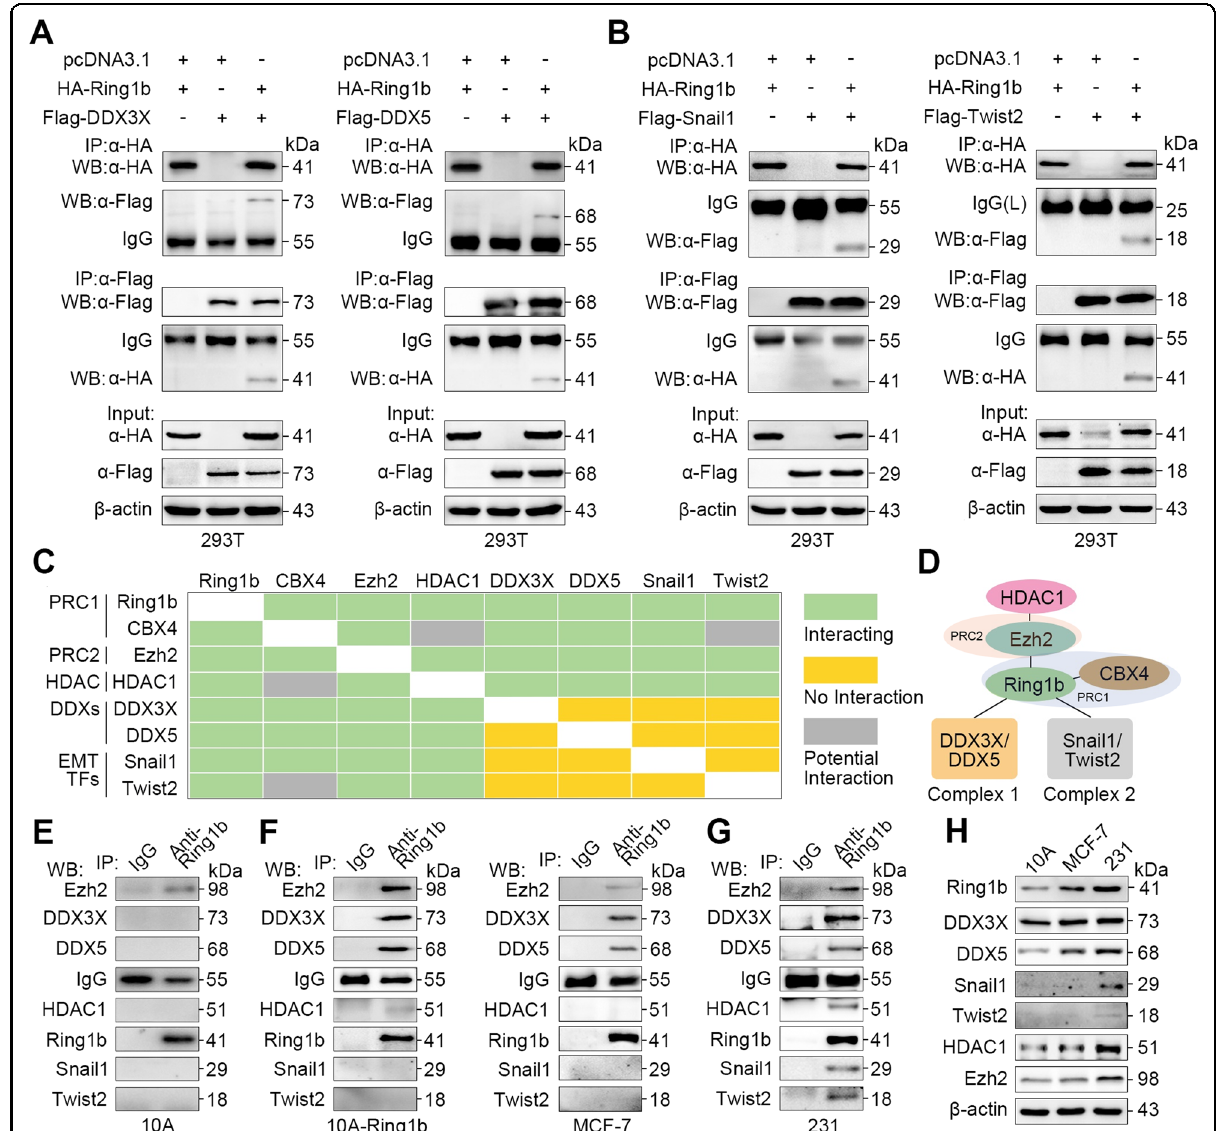
Fig. 2 Veri fi cation of Ring1b-interacting proteins. A, B Ring1b interacts with DDX3X and DDX5, or with Snail1 and Twist2. The 293 T cells were transfected with plasmids as indicated for 24 h. Proteins were captured by IP and analyzed by western blot. C Heatmap of interaction between Ring1b-associated proteins. D Schematic depiction of Ring1b complexes. E – G Ring1b complexes veri fi ed in breast cell lines. Lysates from 10 A, 10A- Ring1b, MCF-7, and 231 cells were analyzed by IP followed by western blot. H Expression of endogenous Ring1b-associated proteins in breast cell lines. Total protein extractions from cells were analyzed by western